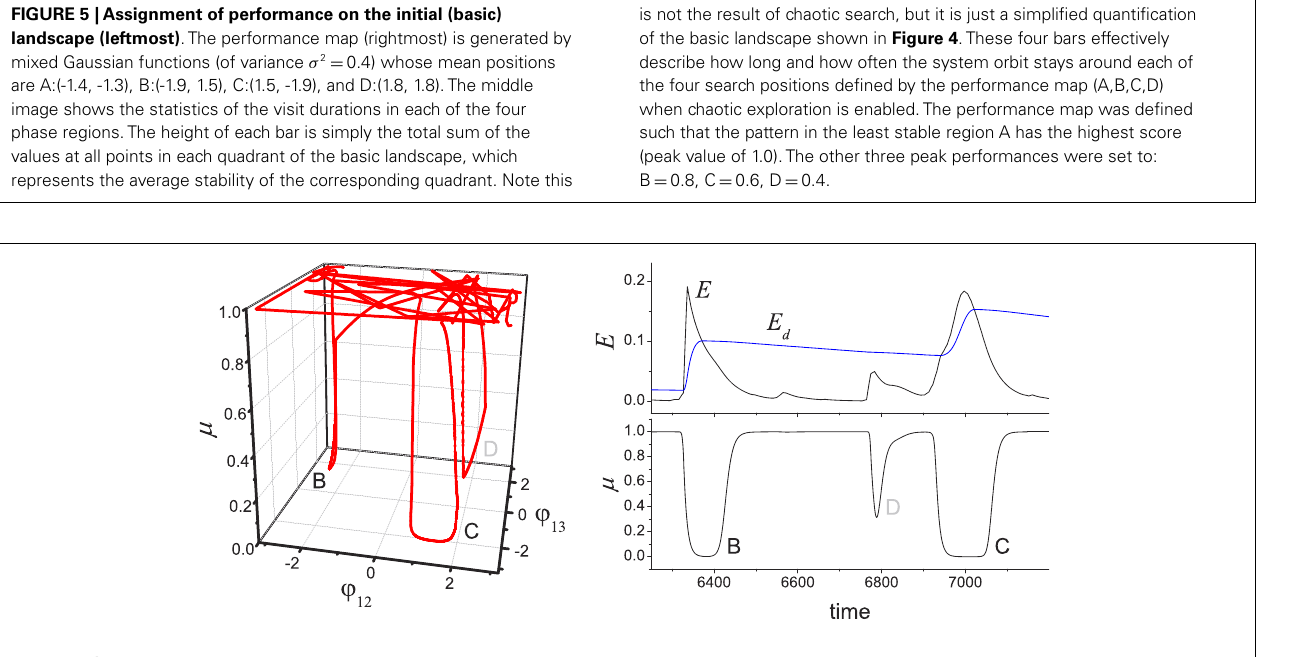
FIGURE 6 | Chaotic jump between attractors . (Left) An example of chaotic exploration is shown in ( ϕ 12 , ϕ 13 , µ ) space, and (right) the time course of performance ( E ) and desired performance ( E d ) is shown with the global